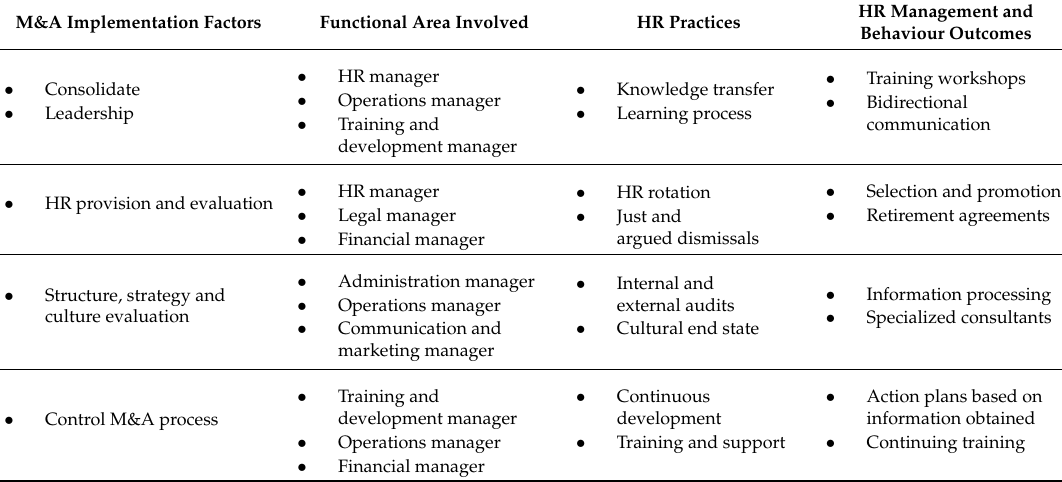
Table 2. Functional areas, HR practices and